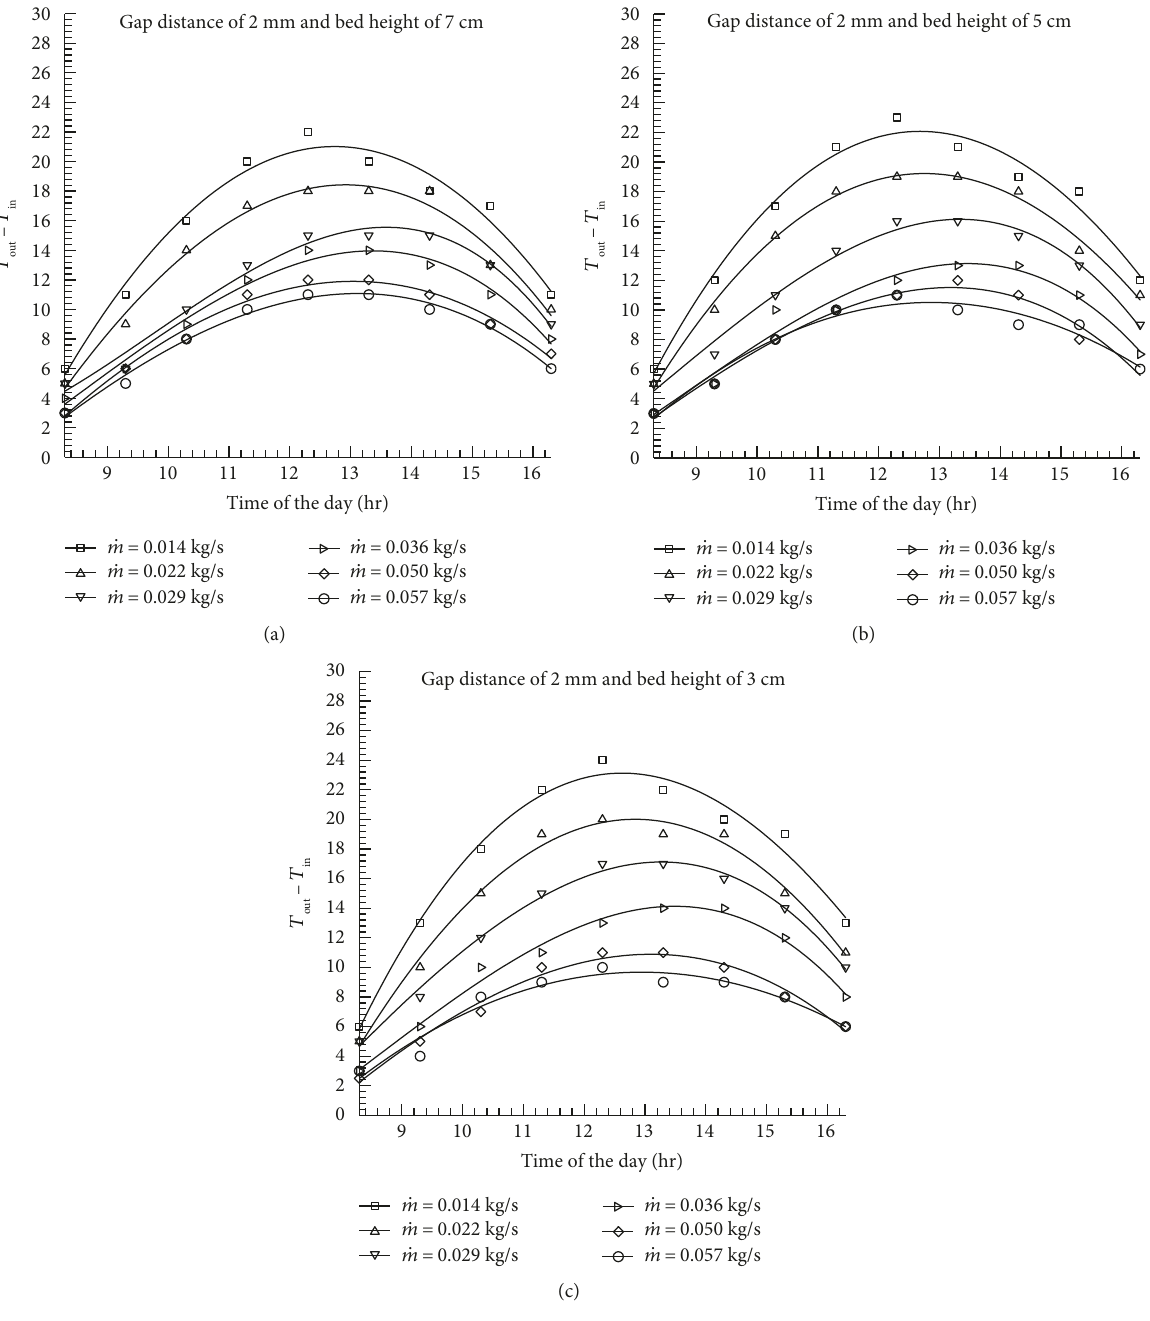
ff erent mass fl ow rates m and three di ff erent bed heights